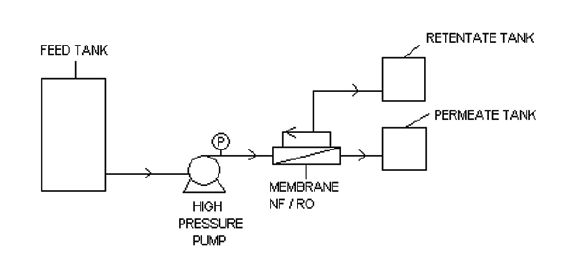
Figure 1. Schematic drawing of the membrane